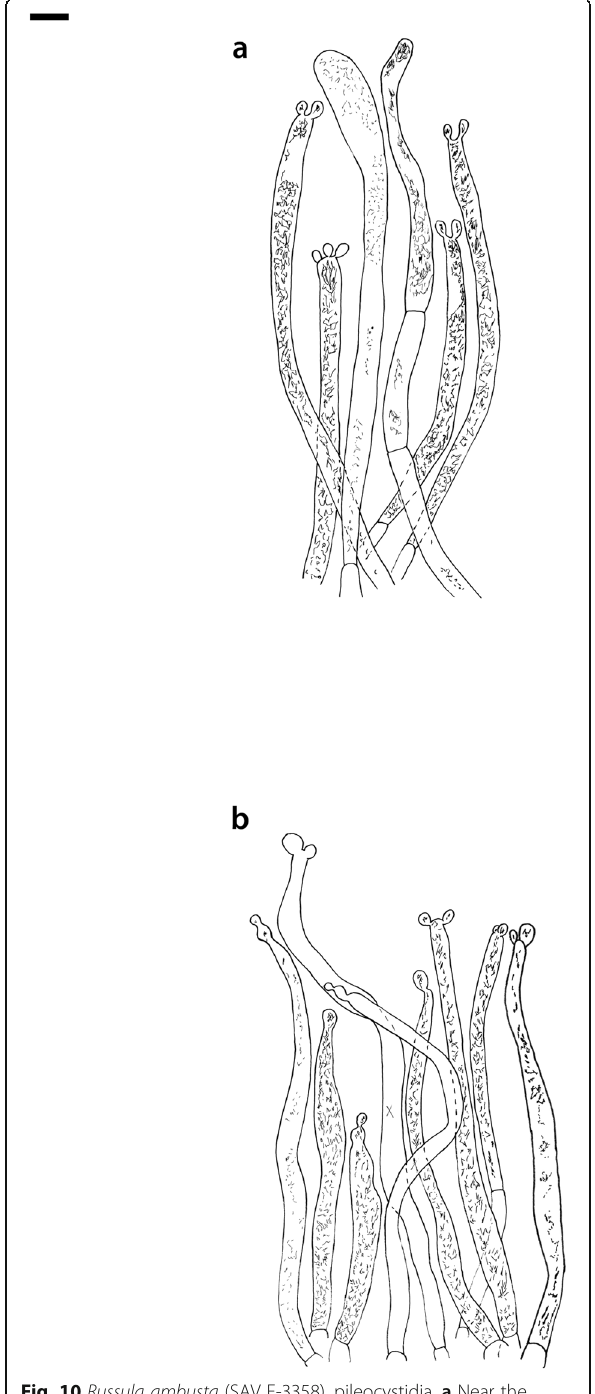
Fig. 10 Russula ambusta (SAV F-3358), pileocystidia. a Near the pileus margin. b Near the pileus centre. Bar = 10 μ